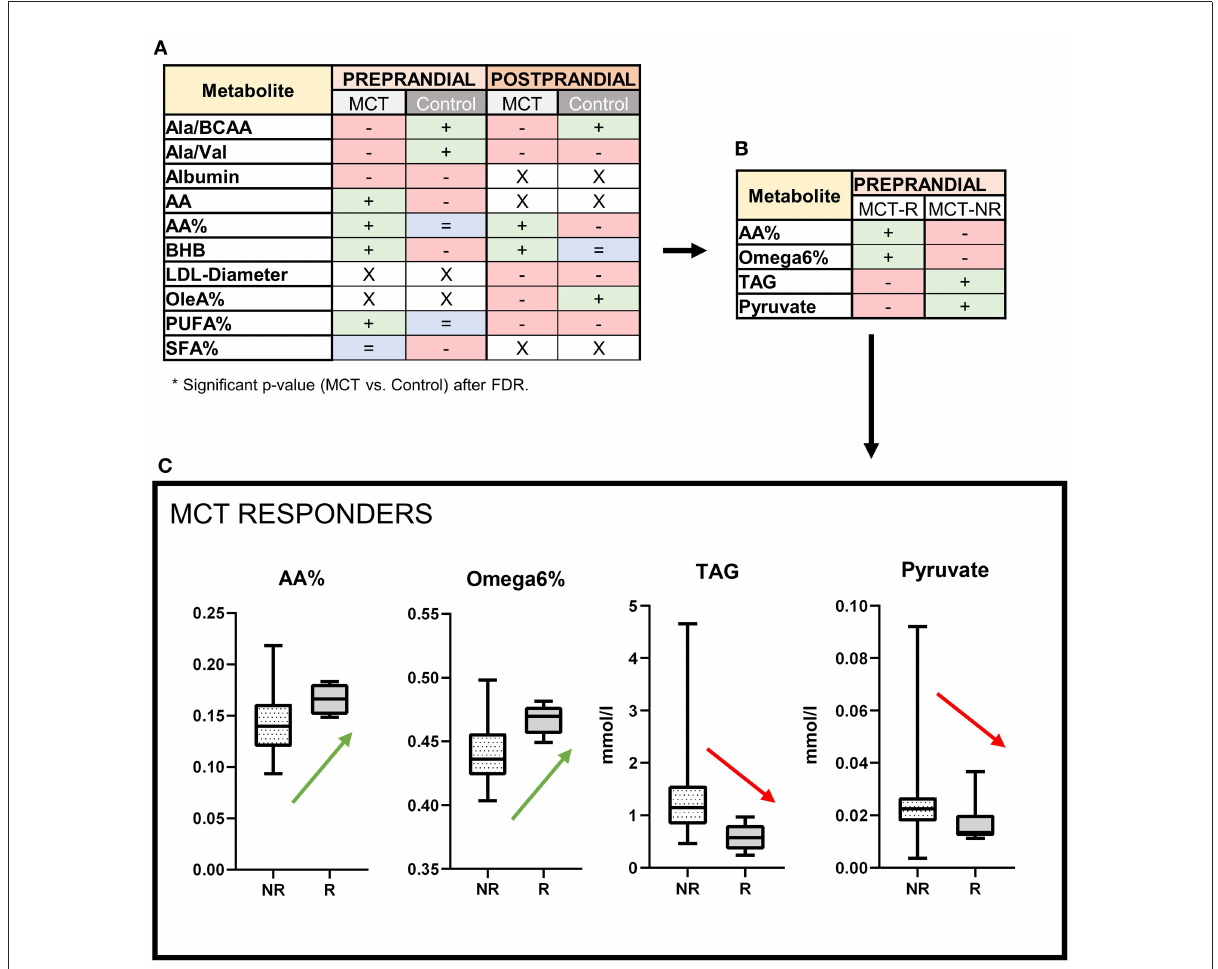
FIGURE3 Serum metabolite profile: Effects of the medium-chain TAG dietary supplement (MCT-DS, light-grey) on serum metabolites compared with the control dietary supplement (Control-DS, dark-grey) in (A) pre-prandial (light-orange) and post-prandial (dark-orange) state ( N = 28). If significant between both dietary supplements (A) , altered parameters are labelled according to their change related to baseline (red = decreased, blue = stable, green = increased, x = not significant). MCT-R (B) showed significant abundances in four different metabolites. MCT-R (C) show a shift in their fatty acid profiles to increased serum levels of arachidonic acid ( P = 0.0283) and (cid:127) 6 fatty acids ( P = 0.0171), but decreased levels of triglycerides ( P = 0.0034) and pyruvate ( P = 0.0386). Data are shown as box-and-whisker plots (central lines of the box represent the median, lower and upper limits of the box represent the 25th and 75th percentiles and whiskers represent the minimum and maximum). Two-sided Wilcoxon’s matched-pairs rank tests were used to compare control and MCT-DS groups. * P <